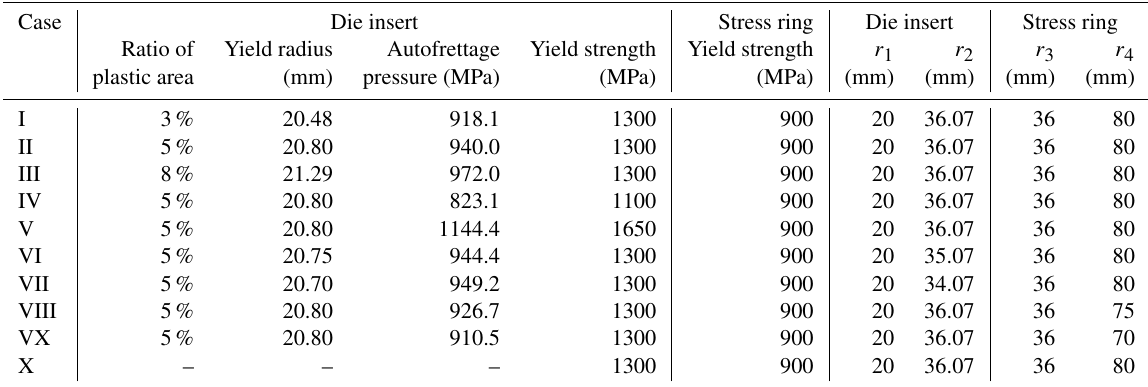
Table 3. Parameters of cases selected for further